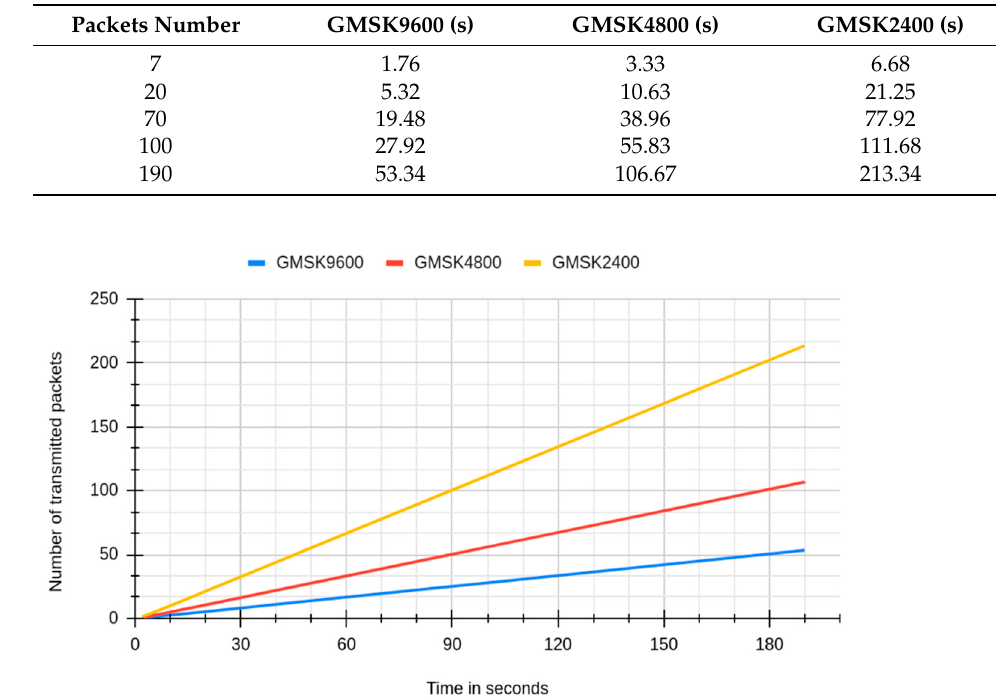
Figure 15. The system packet rate.